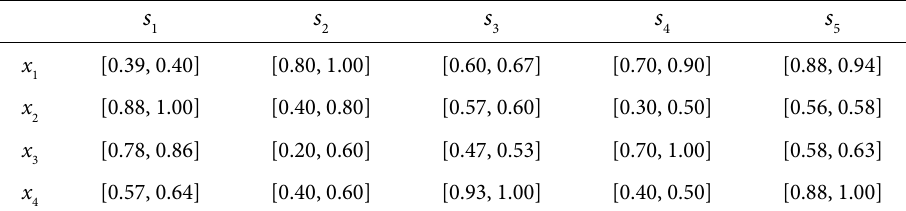
Table 6. Normalized uncertain decision